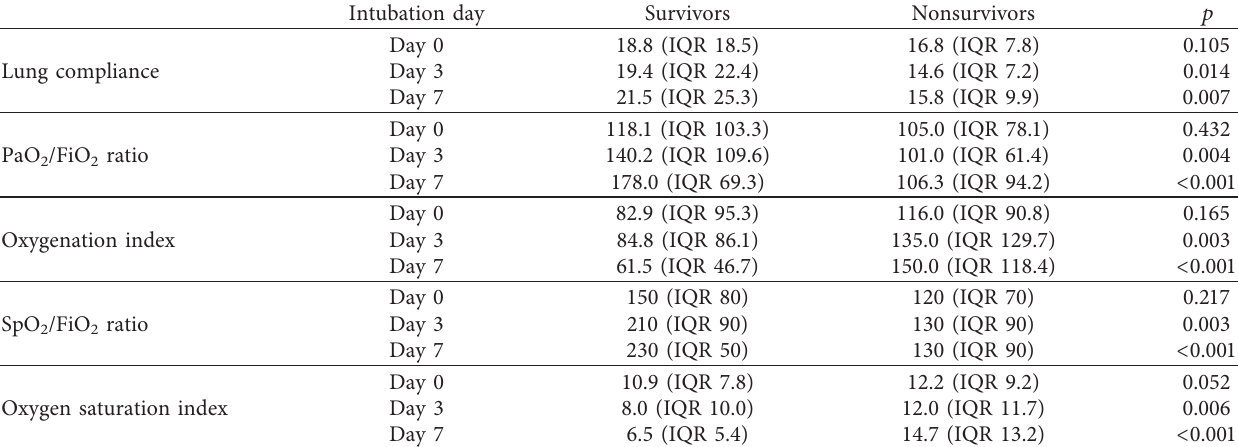
2 /FiO 2 , OI, SpO 2 /FiO 2 , and OSI.